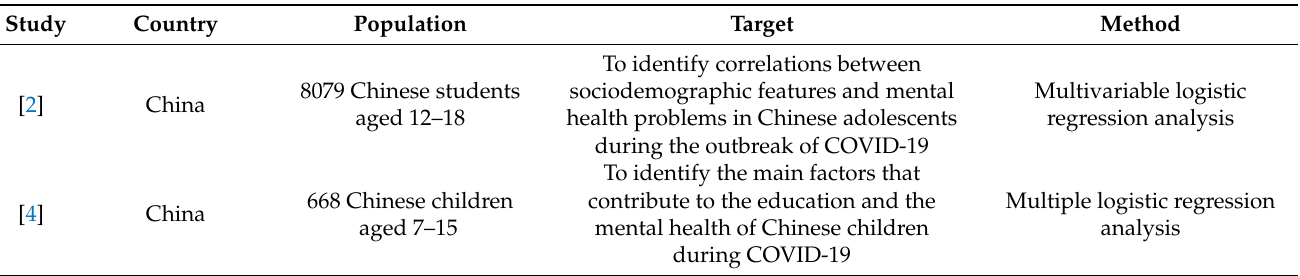
Table 2. Summarization of studies related to the first COVID-19 outbreak, including children and young